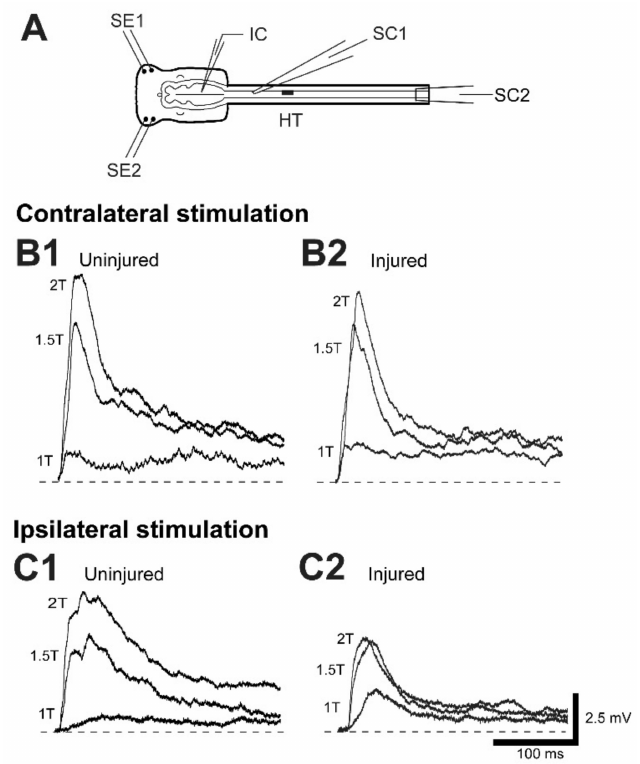
Figure 9. Comparison of sensory-evoked EPSPs recorded from uninjured and injured pairs of RS neurons. ( A ) Diagram of in vitro brain-spinal cord preparation (not to scale) showing the exposed brain (right) and spinal cord (left), right spinal cord HT at 10% BL (2 wk recovery time), intracellular micropipette (IC) for recording from RS neurons, suction electrodes for recording RS neuron-evoked orthodromic action potentials in the spinal cord (SC1 and SC2; see Figure 1B), and right and left oral hood stimulating electrodes (SE1 and SE2). ( B ) Traces of averaged EPSPs for ( B1 ) an uninjured left “B1” RS neuron and ( B2 ) injured right “B1” RS neuron (see Figure 1A) in the same animal evoked by contralateral oral hood stimulation of varying stimulus intensities (1 T, 1.5 T, 2 T; see Methods). ( C ) Traces of averaged EPSPs for ( C1 ) an uninjured left “B3” RS neuron and ( C2 ) injured right “B3” RS neuron in the same animal evoked by varying stimulus intensities applied to the ipsilateral oral hood. Horizontal dashed lines indicate V REST